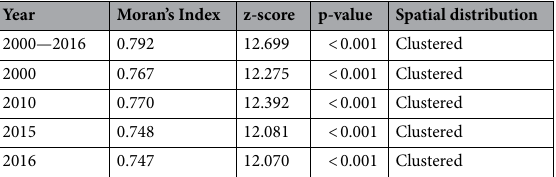
Table 2. Global Moran’s I summary of DALY loss due to LRI for each period analyzed.